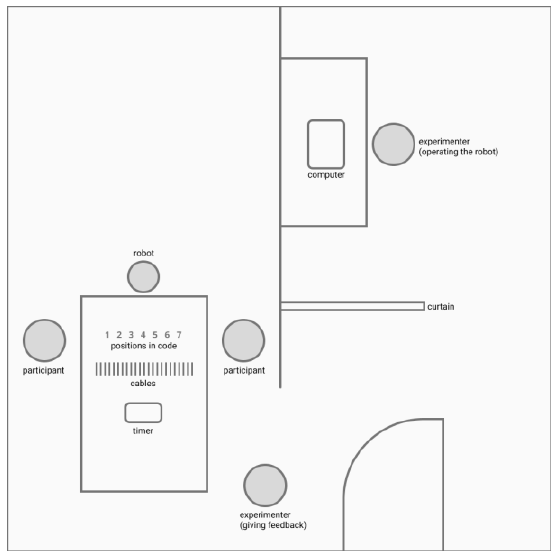
Figure 1. Experimental setup in the laboratory.